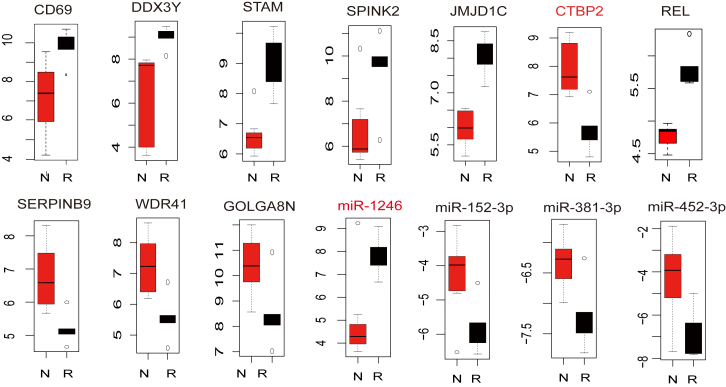
The Expression of DEGs and DEMs with Stable PatternExpression levels of top 5 upregulated and top 5 downregulated DEGs and all DEMs with stable expression profile in relapse and remission samples. R, relapse; N, remission.